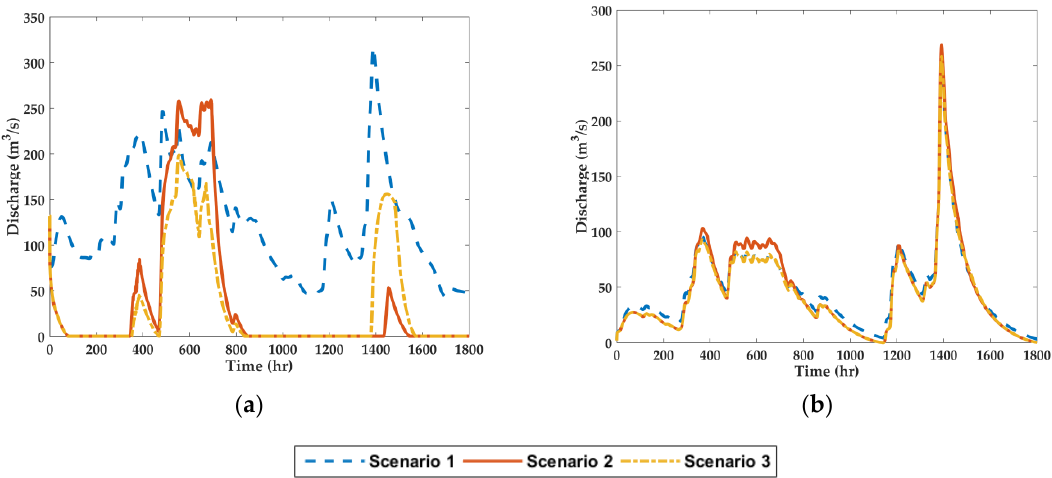
Figure 5. Significant releases from the uncontrolled spillways: ( a ) Lower Paunglaung reservoir and ( b ) Swa reservoir.